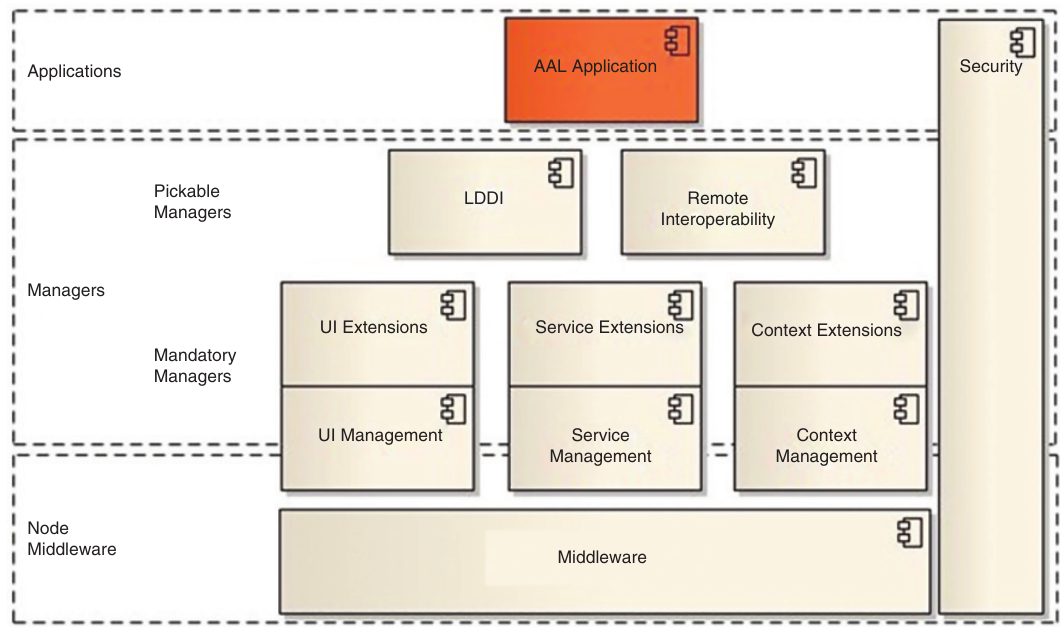
Figure 5: Consolidated Decomposition Model of the Runtime Support Platform at the Level of Abstract Building Blocks.